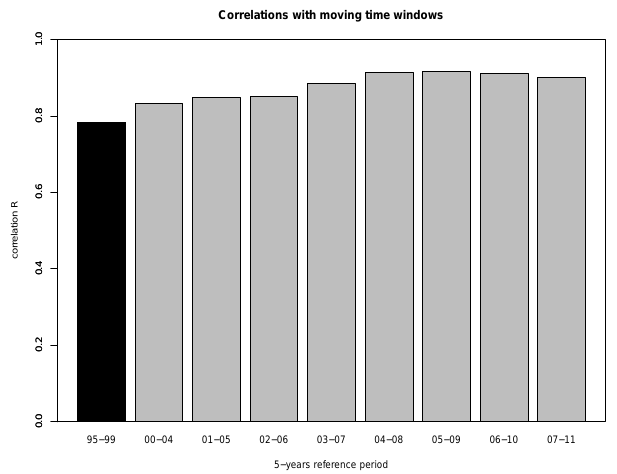
Figure2. Histogramofspatialcorrelations(domain:LAT44–47,LON10–14)betweenlightningdensitiescalculatedforthe5–yearperiod Figure 2. Histogram of spatial correlations (domain: LAT 44– 1995–1999 against the 12–year period 2000–2011 (black bar), and for a running time–window period of 5 years (listed in the abscissa) againsttheremnant12–yearperiod. 47 ◦ N, LON 10–14 ◦ E) between lightning densities calculated for the 5yr period 1995–1999 against the 12yr period 2000–2011 (black bar), and for a running time-window period of 5yr (listed in the abscissa) against the remnant 12yr period (grey